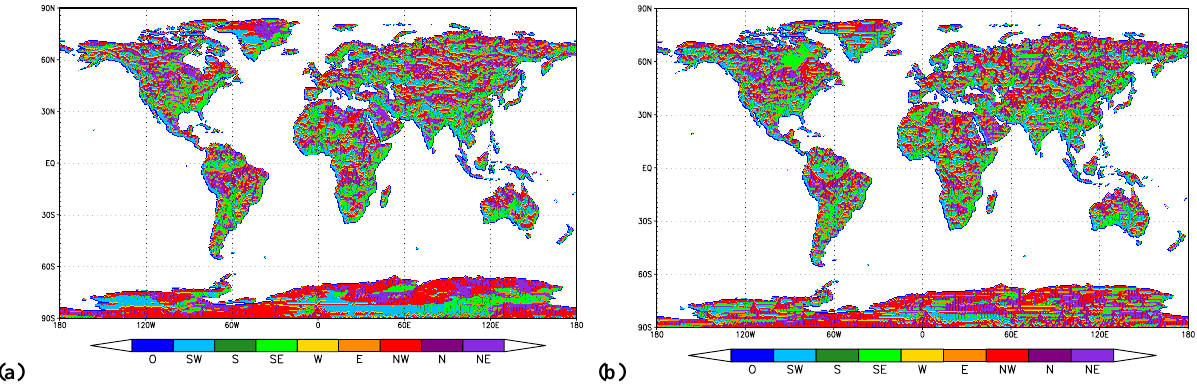
Fig. 4. River directions on the hydrological model grid (0 . 5 ◦ × 0 . 5 ◦ ) of ECHAM5 for PI control (a) and adjusted to Pliocene topography (b) . The colours indicate the flow direction at each grid point; ocean is indicated by white. In addition to the four main and diagonal directions, dark blue (O) marks grid cells where the water flow is directly into the ocean (coastal